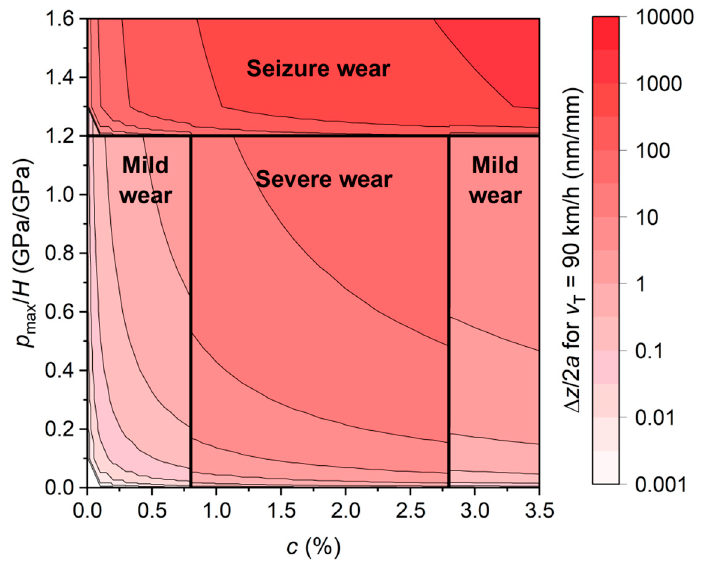
Figure 5. Wear map showing the wear depth per contact length computed using the adapted Archard wear model. The presumed constants are stated in the main text.